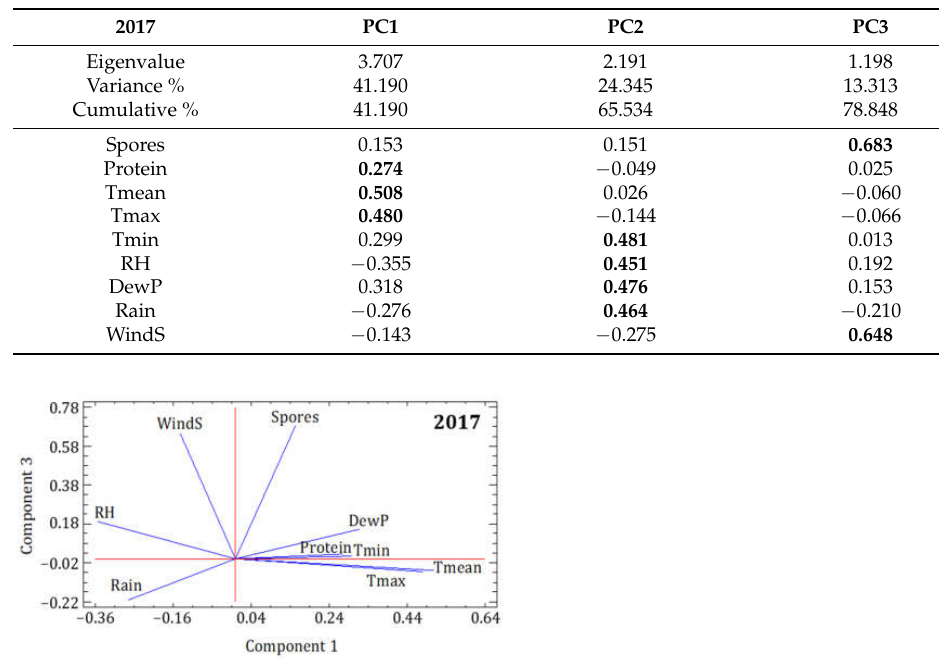
Table 1. Principal Component Analysis coefficients for 2017 and factor loadings of the considered variables. In bold, the largest correlation coefficient for each variable.